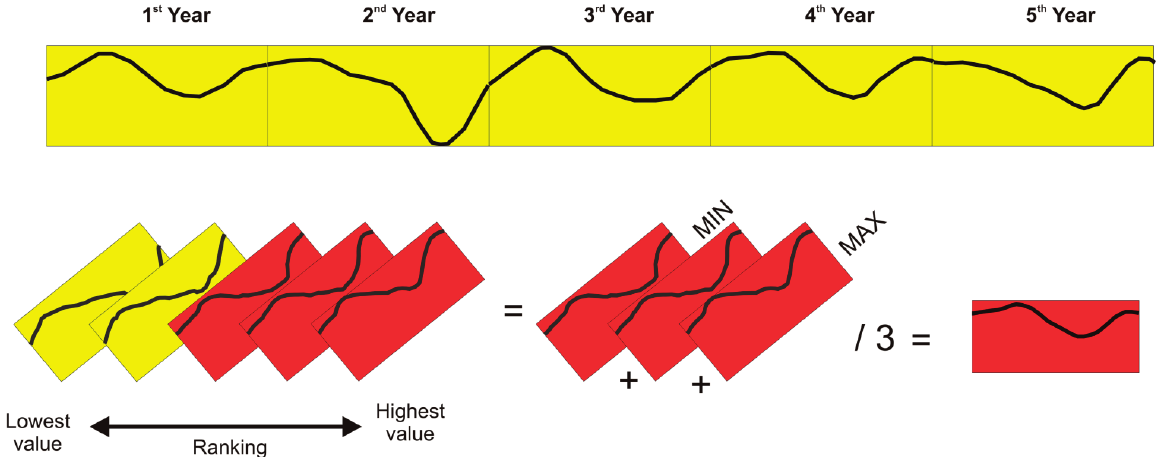
Figure 9. Procedure for calculating the interannual trimmed mean curve, considering one pixel and five